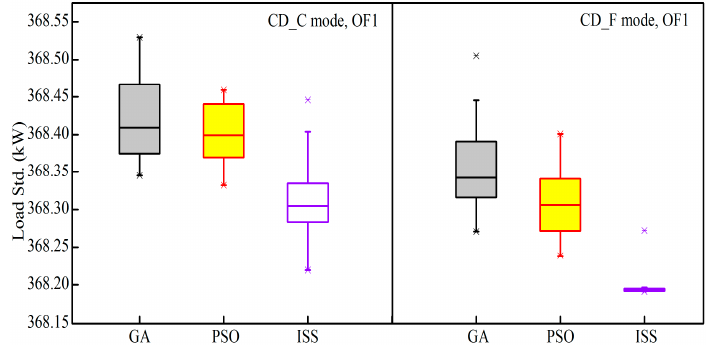
Figure 6. Box-plot for CD_C and CD_F mode with objective OF1.